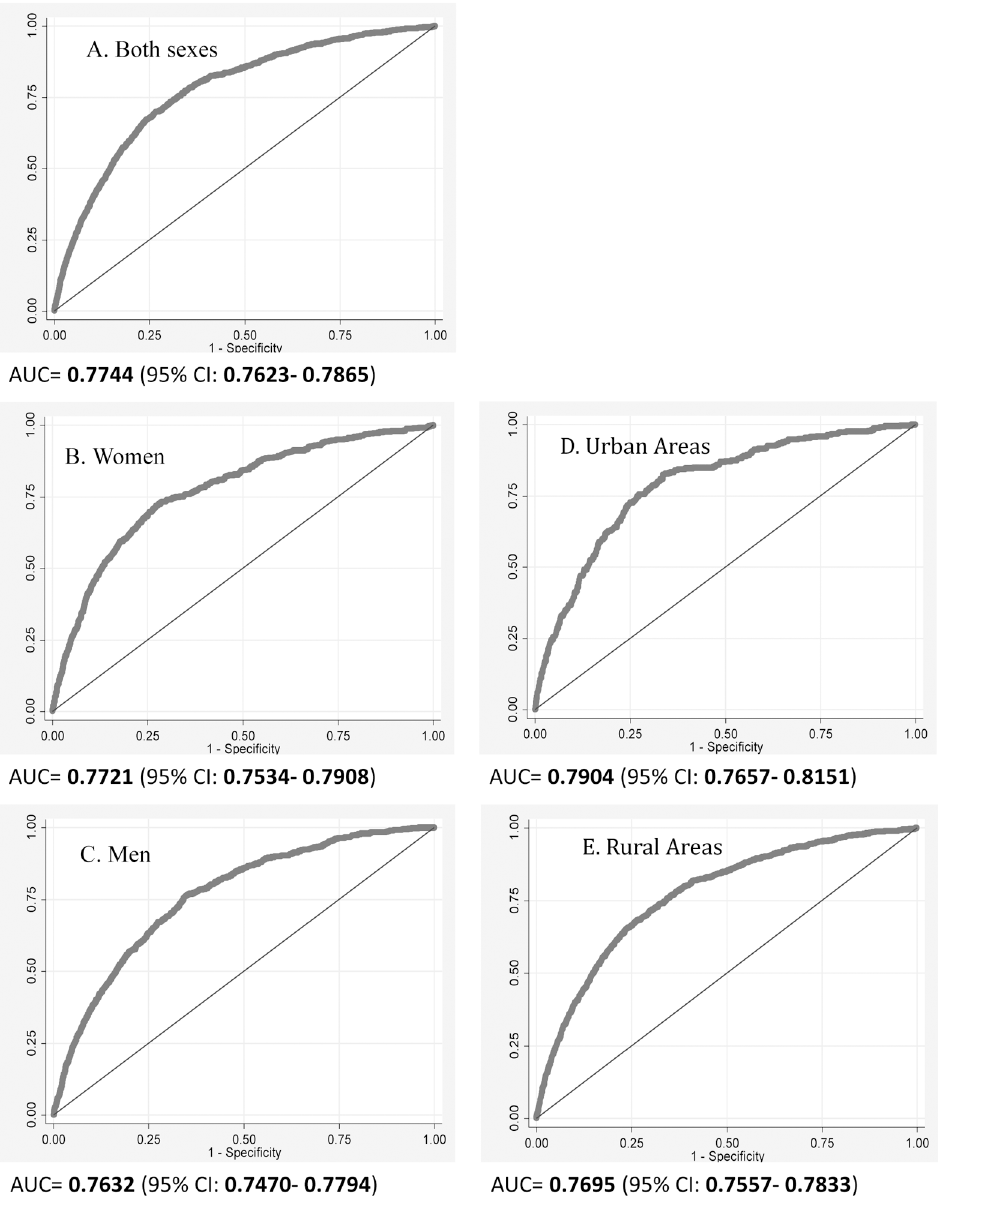
Fig 1. ROC curves of observed 10-year risk versus predicted risk of fatal